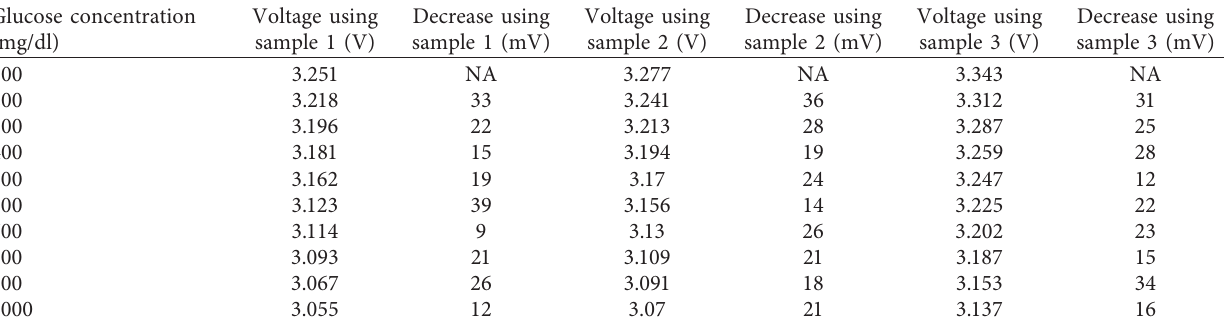
Table 7: Glucose measurement in human blood plasma samples 1, 2, and